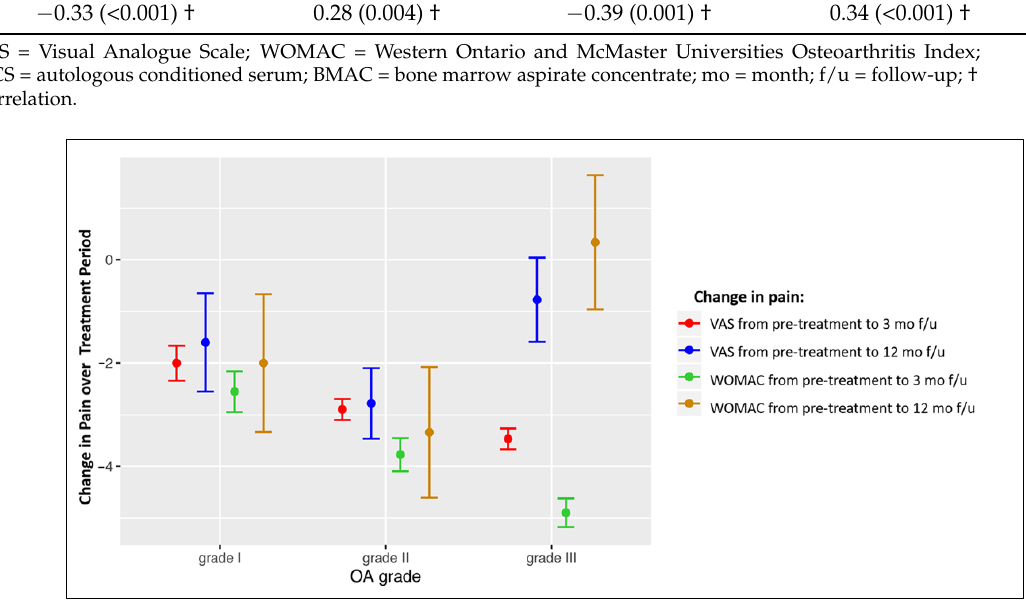
Figure 3. Forest plot showing VAS and WOMAC score changes in patients with different OA grades for the overall study cohort. Mean values of score change ± SEM are presented. OA = osteoarthritis; VAS = Visual Analogue Scale; WOMAC = Western Ontario and McMaster Universities Osteoarthritis Index; mo = months; f/u = follow-up.